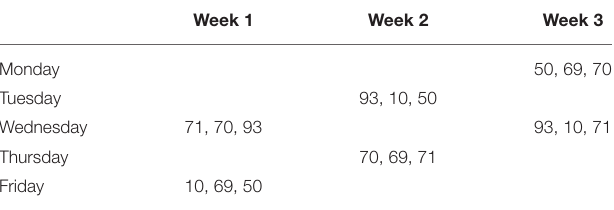
TABLE 1 | Timeline for sample